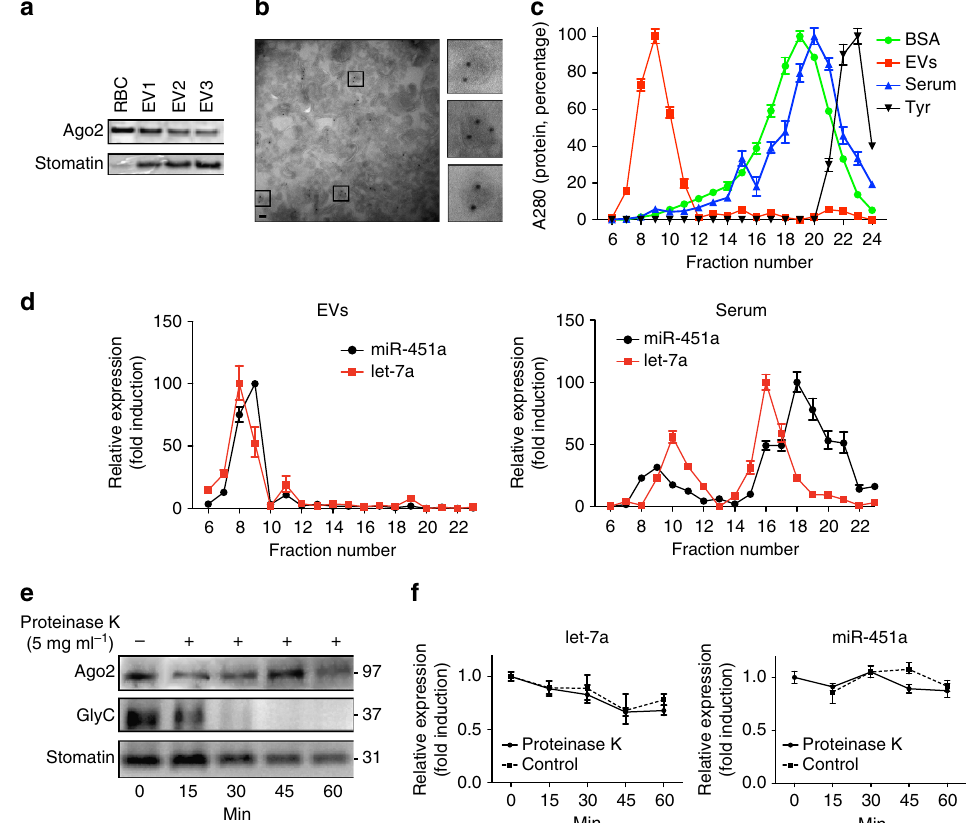
Figure 3 | Ago2 and miRNA are present within purified EVs. ( a ) Expression of Ago2 and stomatin in multiple EV preparations was probed by western blot. ( b ) Immuno electron microscopy. EVs were prepared and processed as described in materials and methods for labelling with human Ago2 antibody. The field of view shows multiple EVs with internal immunogold labelling, demonstrating that Ago2 is present in EVs rather than associated by surface attachment. Inserts: three representative EVs in higher magnification (scale bar, 100nm). ( c ) Elution profile of purified EVs, human serum, BSA and tyrosine (Tyr) after size-exclusion separation. Protein abundance was determined by absorbance at 280nm. Points represent the mean ± s.d. of three experiments performed in triplicate. ( d ) Fractions from purified EVs (left) and serum (right) were assayed for miR451a (black) and let-7a (red) using absolute quantification by TaqMan qPCR. The mean ± s.d. of one representative experiment is shown ( n ¼ 2). ( e , f ) The Ago2-miRNA complexes are protected from protease K digestion. ( e ) EVs were treated with proteinase K (5mgml (cid:2) 1 , or untreated control) at 55 (cid:2) C. At times indicated, aliquots were removed and assessed for Ago2, stomatin and Glycophorin C expression by western Blot. In contrast to Glycophorin C, Ago2 and stomatin were protected from digestion by proteinase K. ( f ) Untreated (open symbols) or treated samples (close symbols) were also analysed for miR-451a and let-7a expression by qPCR. Points represent miRNA copies detected at each time relative to the control sample at time point 0. The mean ± s.d. of one representative experiment is shown ( n ¼ 3). qPCR, quantitative